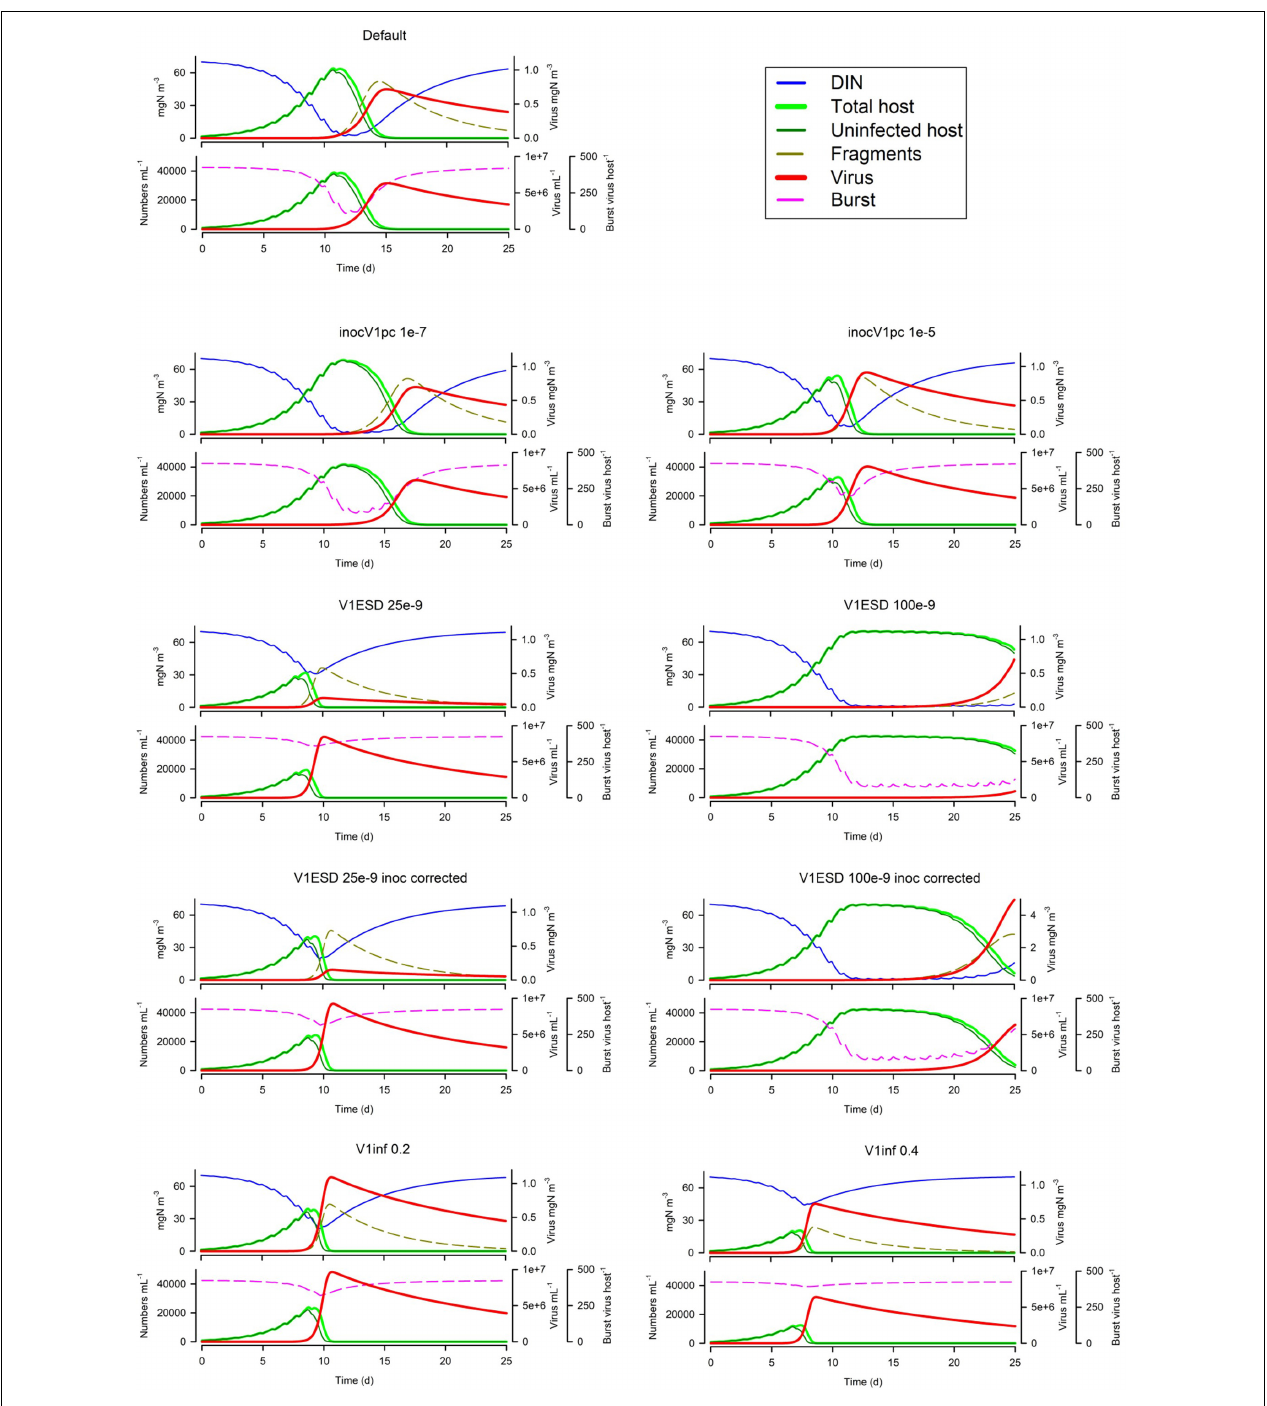
FIGURE 8 | Effects of virus inoculum size as a proportion of the nutrient load (1E-7 or 1E-5 vs Default of 1E-6), virus ESD (25E-9 m or 100E-9 m vs Default of 50e-9 m) with the same biomass inoculum, virus ESD with the same numeric abundance inoculum through adjustment of the virus biomass inoculum, and virus infectivity ( V1inf 0.2 or 0.4 vs Default of 0.1). The Default ( Figure 1B ) is reproduced in the top left-hand corner. See also Table 5